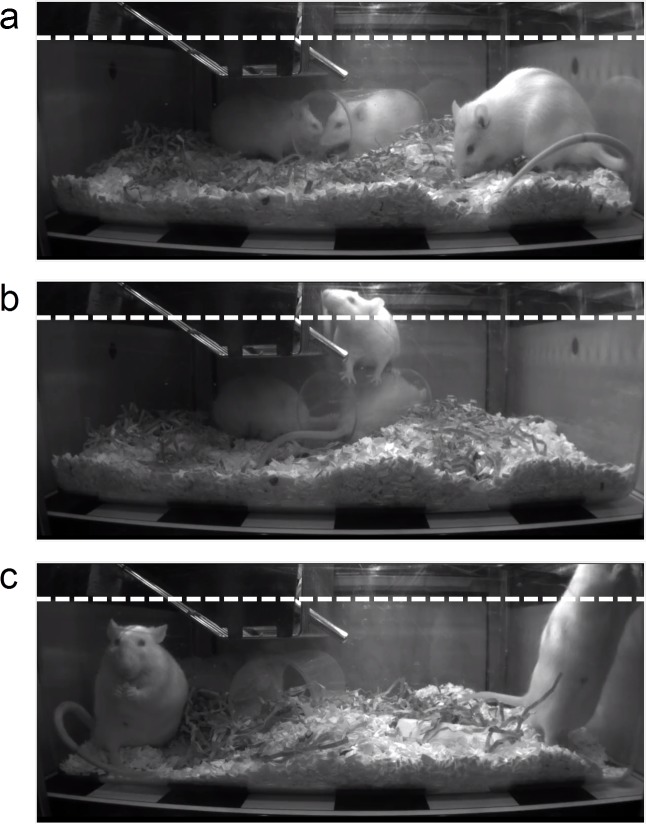
Assessing the precision of the vertical activity measure.(a-c) Still images from side-mounted HD camera showing position of arbitrary cut-off line to define ‘vertical activity’ (image movement detected above dotted line). (a) No vertical activity, no rearing; (b) vertical activity not due to rearing (rat in center of image is climbing on plastic play tunnel); (c) vertical activity due to rearing (rat on right of image; the rat on the left of the image is eating from its forepaws. Note that the automated detection of vertical activity is not exactly equivalent to rearing behavior, as vertical activity also includes climbing on the play tunnel and (particularly when rats are in the foreground of the image) tail elevation, transient postural elevation during shaking during grooming, and jumping on cagemates during play fighting. Conversely, some rearing in the background of the image is partly obscured by the food hopper or may not quite reach the level of the cut-off line.